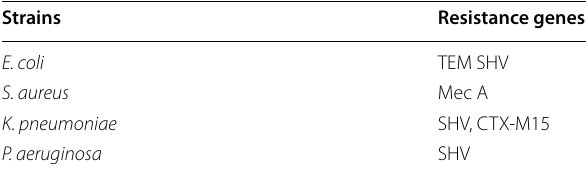
Table 5 Resistance gene profile of isolated strains